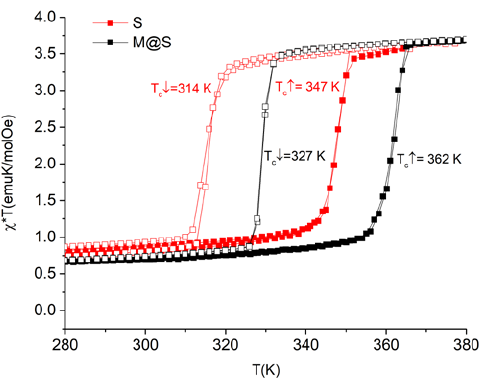
Figure 5. The thermal-variable magnetic curves for compound S and M@S (two cycles), the solid dots represent heating progress, and the blank dots stand for cooling procedure.